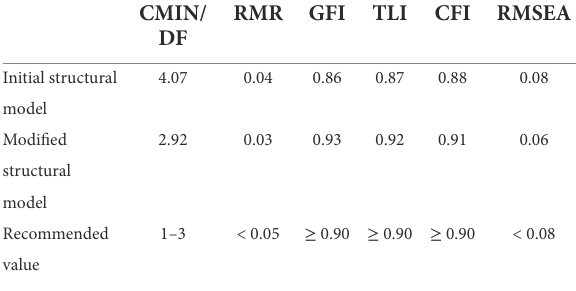
Initial structural model: the structural model before deleting Q22. Modified structural model: the structural model after deleting Q22, and modified model according to the modification